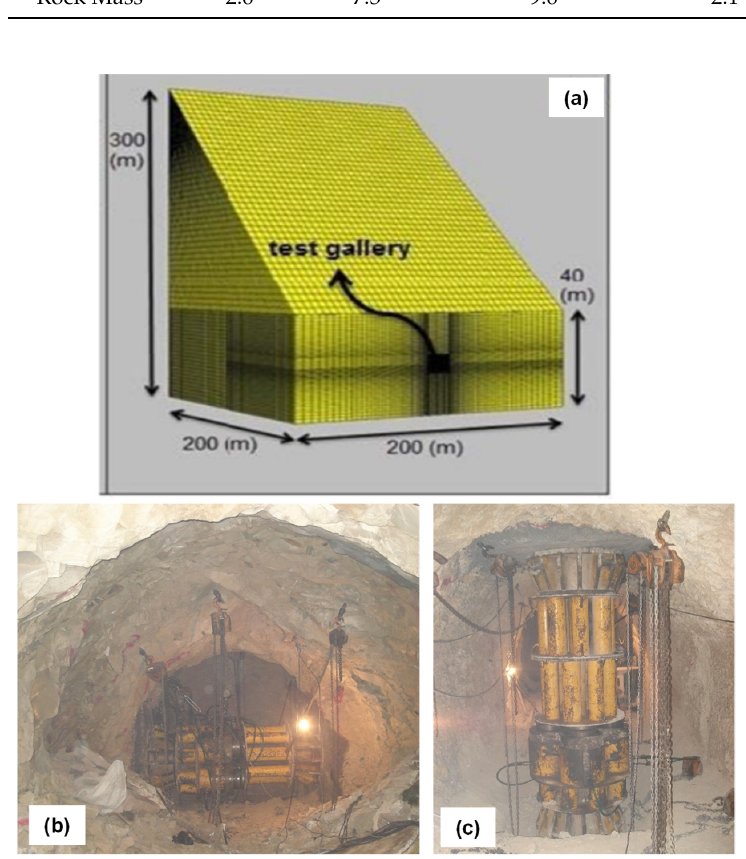
Figure 6. ( a ) View of the Bazoft dam right abutment Flac-3D model, ( b ) View of the simulated test gallery and the horizontal PLT set up, ( c ) View of the vertical PLT set up.